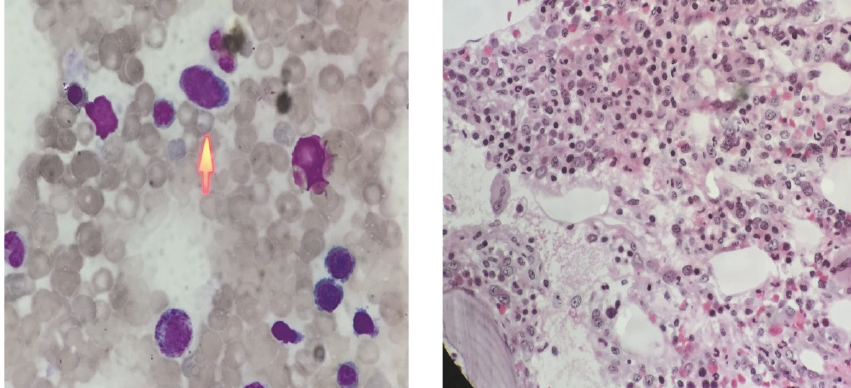
Figure 4: Bone marrow smear and biopsy showed active hyperplasia, immature lymphocytes accounting for 3% of heterotypic large cells with scattered